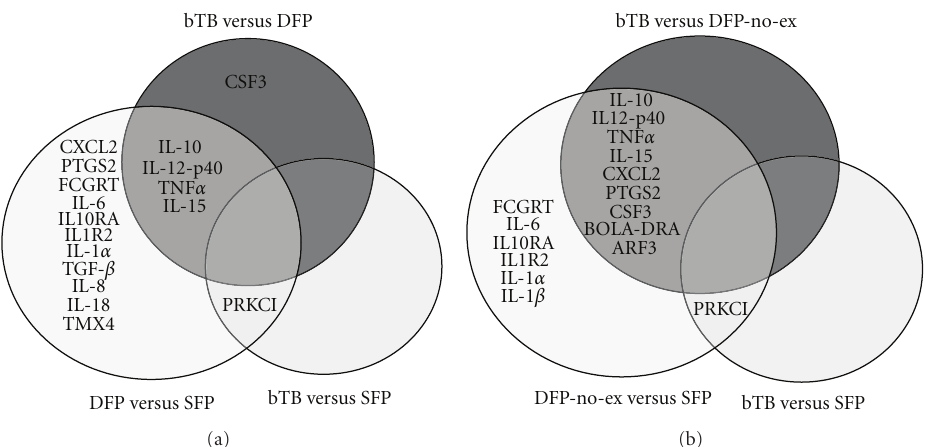
Figure 4: Venn diagrams showing the statistically significant (adj P ≤ 0 . 05) di ff erentially expressed genes that were unique to or common among (a) single antemortem test-false positive (SFP), double antemortem test-false positive (DFP), and bTB-infected (bTB) groups of cattle in initial analysis of 30 cattle and (b) single antemortem test-false positive (SFP), double antemortem test-false positive non-bTB-exposed (DFP-non-ex), and bTB-infected (bTB) groups of cattle after removal of bTB-exposed cattle from the DFP group. The gene expression levels were determined by qPCR assay, where each animal was calibrated relative to the reference pool of RNA from healthy cattle; di ff erential expression between 2 groups of cattle (i.e., X versus Y ) was determined using ANOVA analysis.